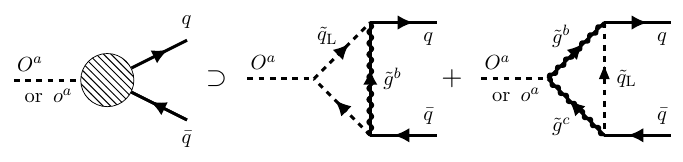
Figure 2 . Representative diagrams for sgluon decays to quark-antiquark ( q ¯ q ) pairs in minimal models with Dirac gauginos [63]. Similar diagrams with right-handed squarks ˜ q R exist in those models. Other loops generate scalar decays to gg or gγ / gZ